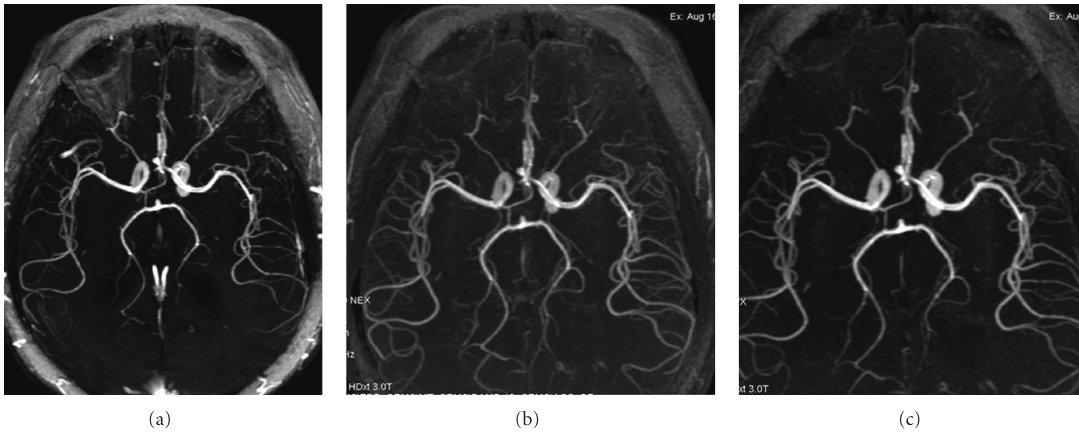
Figure 1: (a) 3D TOF MRA at 3T at the level of the circle of Willis performed without MT or FS and without application of parallel imaging (ASSET). The scan time was 4 minutes and 53 seconds. Intraorbital fat signal is not completely compressed and is superimposed on the images, obscuring the visualization of the ophthalmic arteries. (b) 3D TOF MRA at 3T at the level of the circle of Willis performed without MT but with FS and with the application of parallel imaging (ASSET). The scan time was 2 minutes and 34 seconds. Intraorbital fat signal is completely compressed, and only the arteries are clearly visualized. (c) 3D TOF MRA at 3T at the level of the circle of Willis performed with MT, with FS, and with the application of parallel imaging (ASSET). The scan time was 2:03 min. The arteries are much clearly identified. All images clearly show the Acom aneurysm, but images with application of FS and MT are much clearer and required the shorter scan time.